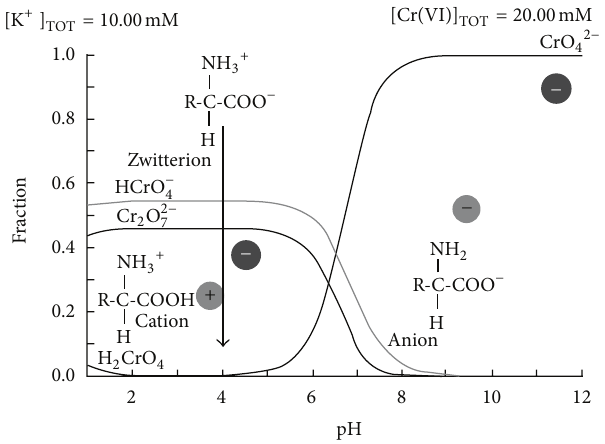
Figure 8: Distribution of Cr(VI) species as a function of pH.